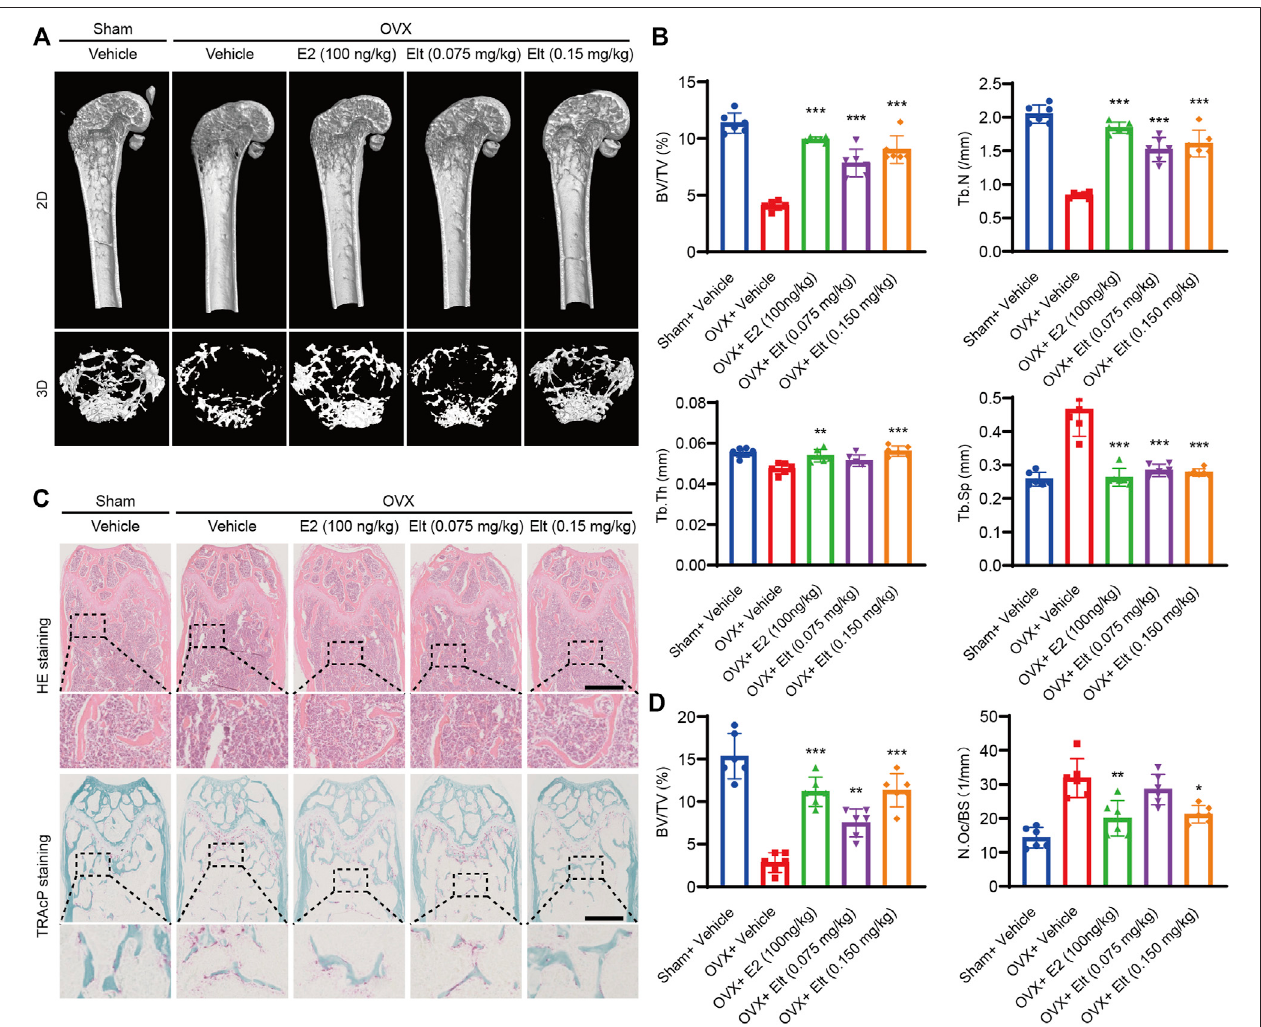
FIGURE 8 | Elt attenuates bone loss caused by ovariectomy. (A) Femur structures in each group were captured by high resolution μ CT and postprocessed by 2D or3Dcomputerreconstruction. (B) Quantitativeanalysesofparametersregardingbonemicrostructure. (C) RepresentativephotographsofHEandTRAcPstainingfrom eachtreatmentgroup(scale=500 μ M). (D) QuantitativeanalysisofBV/TVofHEandthenumberofTRAcP + osteoclastsineachgroup.Theabovedataareexpressedas the mean ± SD; n = 6; Signi fi cant differences between the treatment and control groups are indicated as *p < 0.05.